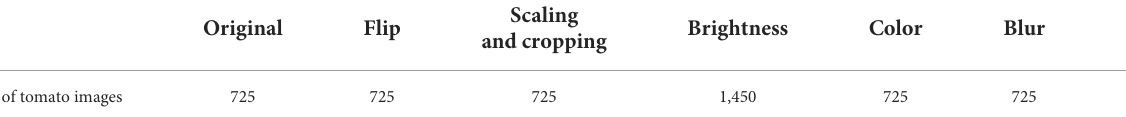
TABLE 1 The number of training images after data augmentation.